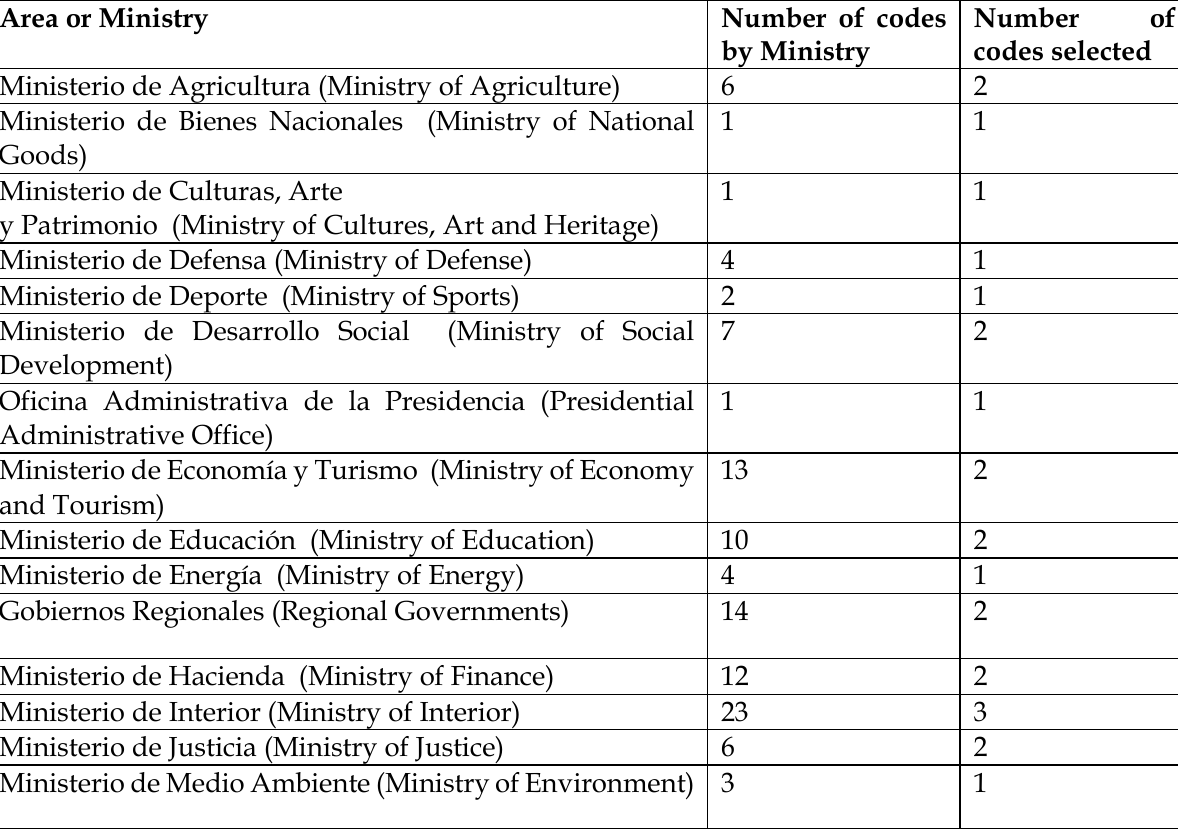
Table 1: Codes of Ethics selected by Ministry Area or